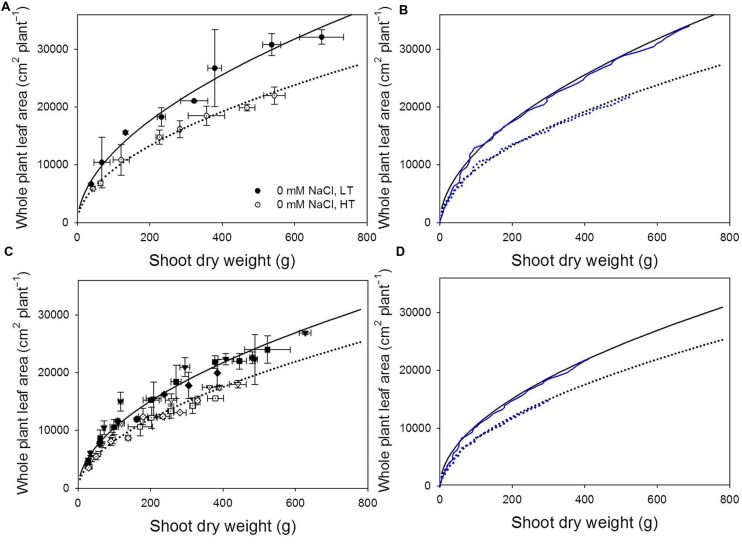
Measured (A,B) and simulated (C,D) allometric relationships between shoot dry weight and whole plant leaf area (cm2 plant-1) at 22/18°C (LT, closed symbols and solid lines) and 32/28°C (HT, open symbols and dotted lines) day/night temperature regimes under non-stress (A) and under 40, 60, and 80 mM NaCl (reversed triangle, square, and rhombus symbols, respectively; B). Black lines represent the regression lines fitted by the data collected from the experiment for model evaluation according to Eq. 2a (non-stress, A,C) and Eq. 2a (salinity stress, B,D). The blue lines show the simulated allometric relationships using light use efficiency equal to kT,x⋅𝜀(Iabs(t)).